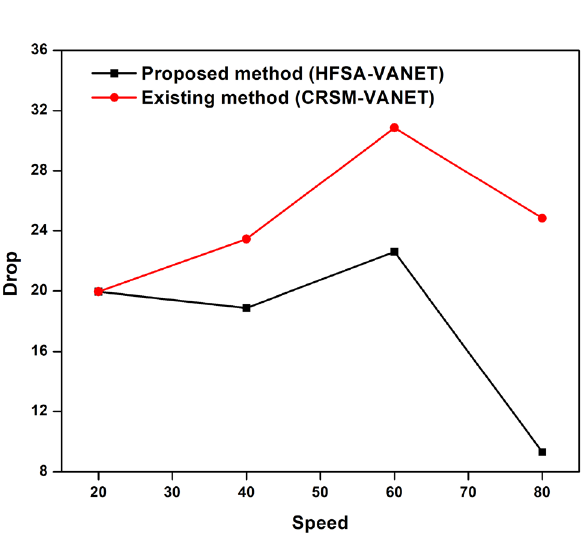
Figure 10. Speed vs drop plot for a proposed and existing method.